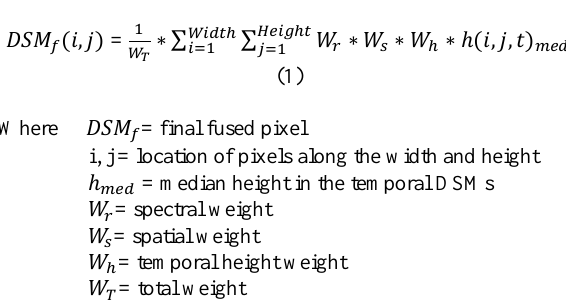
Figure 2. Pre-processing steps. Note h1, h2, and t are empirically determined based on the dataset.